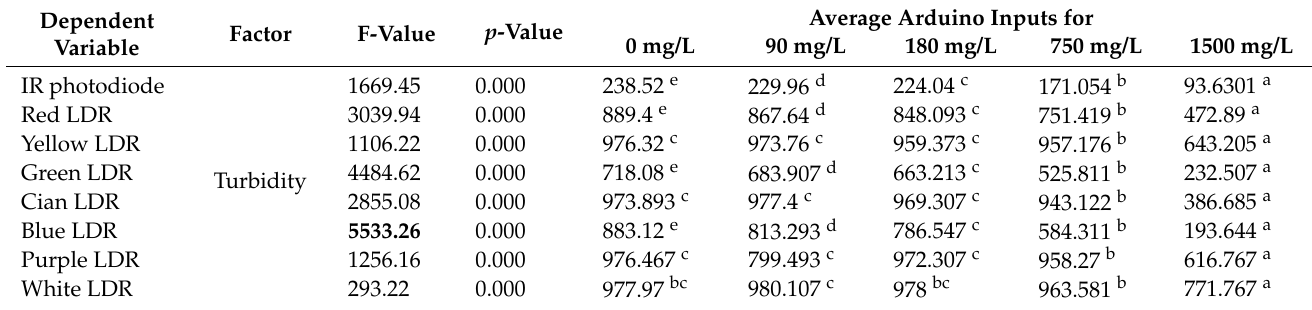
Table 3. Summary of ANOVAs for